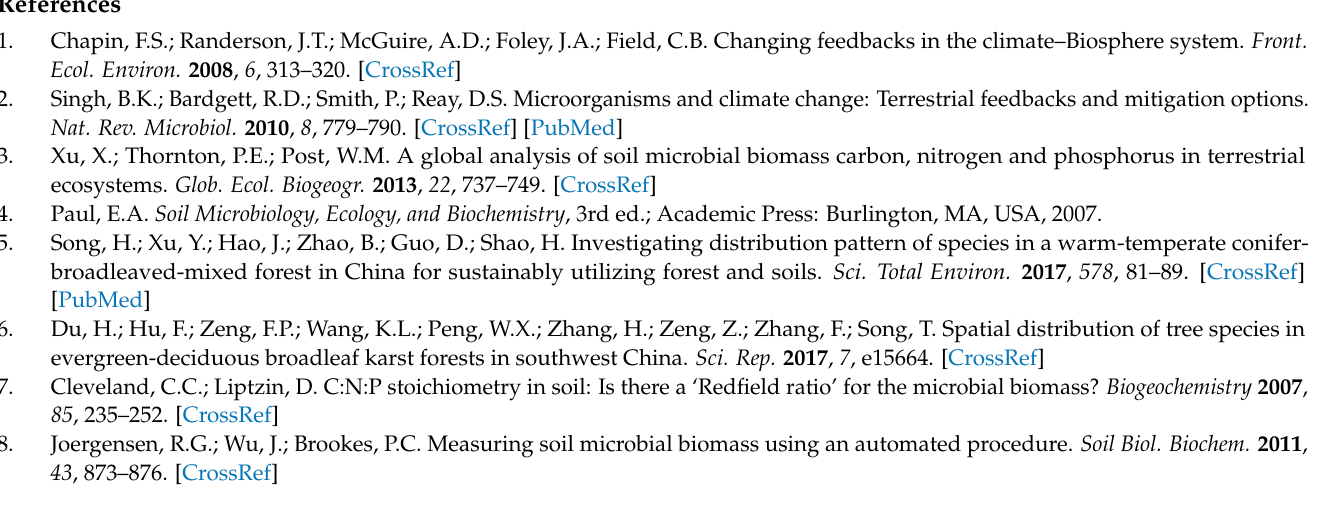
Figure S5. Redundancy analysis (RDA) of carbon resources utilization and environmental factors in forest